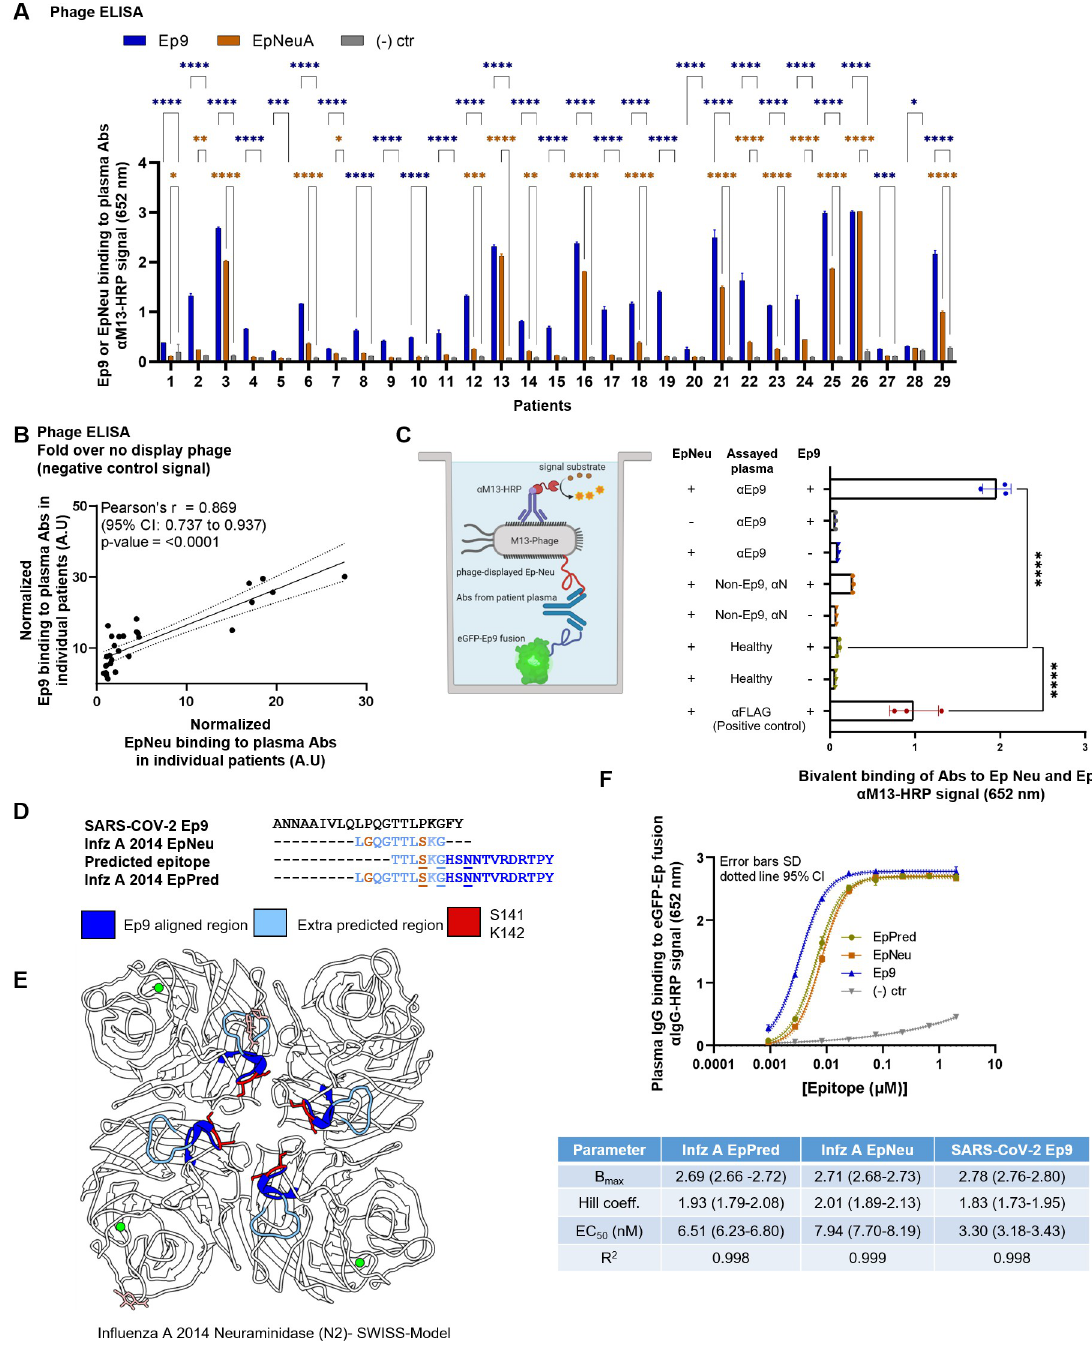
Fig 2. Cross-reactive Ab binding to both Ep9 and EpNeu, and EpNeu epitope prediction. (A) Phage ELISA using 29 previously tested α Ep9(+) COVID-19 patients. The ELISA demonstrated binding of patient plasma Abs to SARS-CoV-2 epitope, Ep9, or the influenza A neuraminidase epitope, EpNeu. Plasma Abs from 16 out of 29 patients Ep9(+) patients showed significant binding to EpNeu. ( ���� p < 0.0001, ��� p < 0.001, �� p < 0.01, � p < 0.05, two-way ANOVA ad hoc Tukey test shown) Significant differences in epitope binding in comparison to the no peptide displayed phage signals are denoted as blue for Ep9 and orange for EpNeu. (B) Comparing normalized levels of phage-displayed Ep9 and EpNeu binding to plasma-coated wells from individual α Ep9(+) patients (n = 29). A strong correlation is observed, as shown by the depicted statistics. Each point in panels A through C represents data from individual patients. (C) A schematic diagram of the sandwich ELISA to examine cross-reactivity of α Ep9 Abs. The assay tests for bivalent Ab binding to both Ep9 and EpNeu. Pooled plasma from five α Ep9(+) patients or five α Ep9( − ) patients with other α NP Abs was tested for bivalent binding to both eGFP-fused